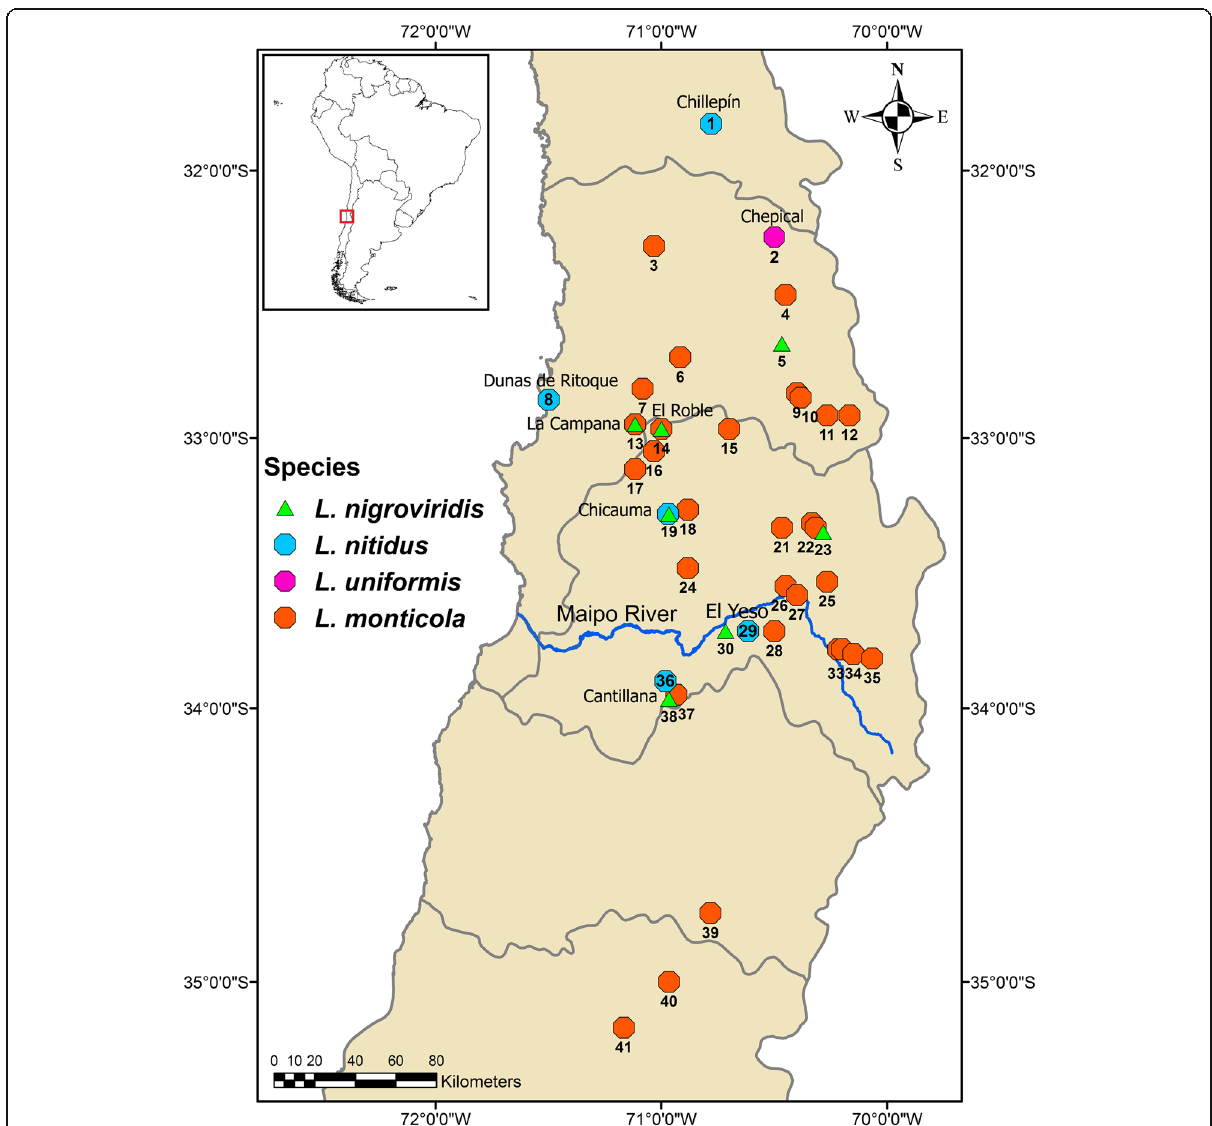
Fig. 1 Study area. Map of 41 localities of focal species. The colors represent the four different species : L. nigroviridis ( green ), L. uniformis ( pink ), L. monticola ( orange ) and L. nitidus ( light blue ). The Maipo River is shown to represent the geographic barrier to the northern and southern clades of L. monticola reported by